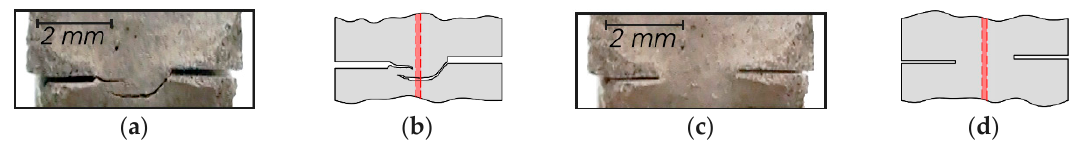
Figure 12. ( a ) and ( b ) Fracture pattern on the notch at the upper reversal point, ( c ) and (d) the Figure 12. ( a , b ) Fracture pattern on the notch at the upper reversal point, ( c , d ) the deformed shape of deformed shape of the specimen at the lower reversal point. the specimen at the lower reversal point.